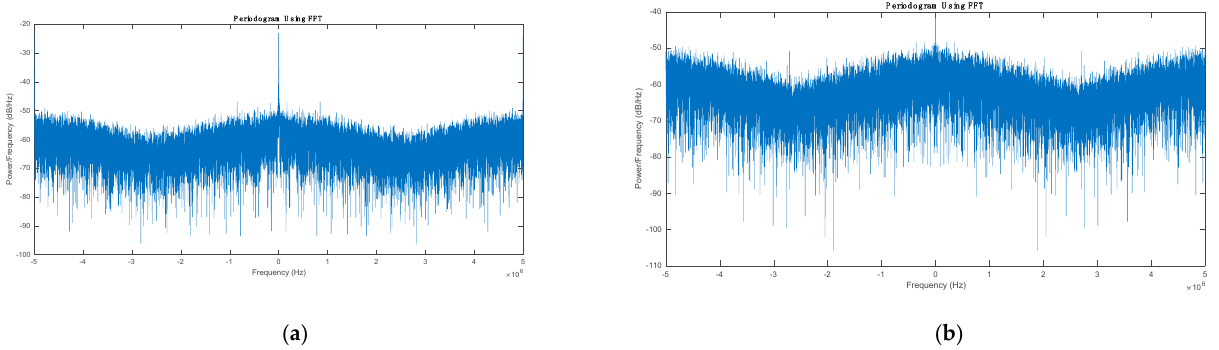
Figure 7 . Power spectral density. ( a ) Before applying the proposed method; ( b ) after applying the proposed method.